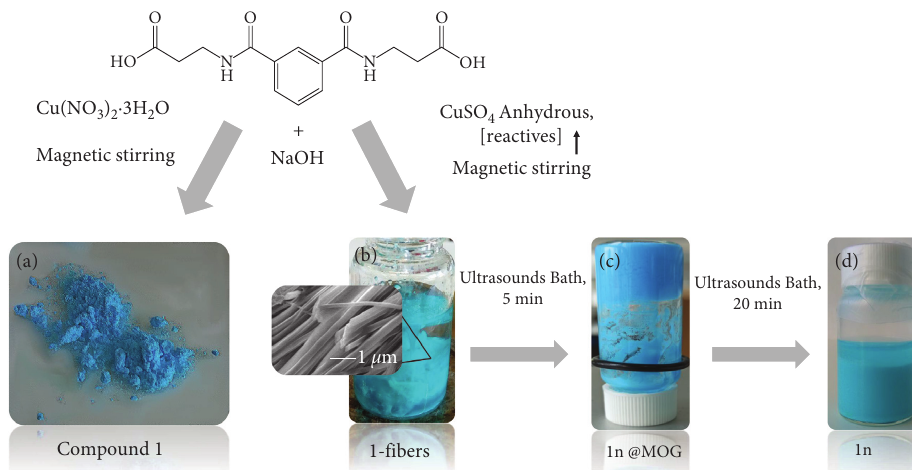
Figure 1: Different conditions to obtain compound 1 as bulk material (a), fibers, 1-fibers (b), metal-organic gel, 1n @MOG (c), or nanocrystals, 1n (d).